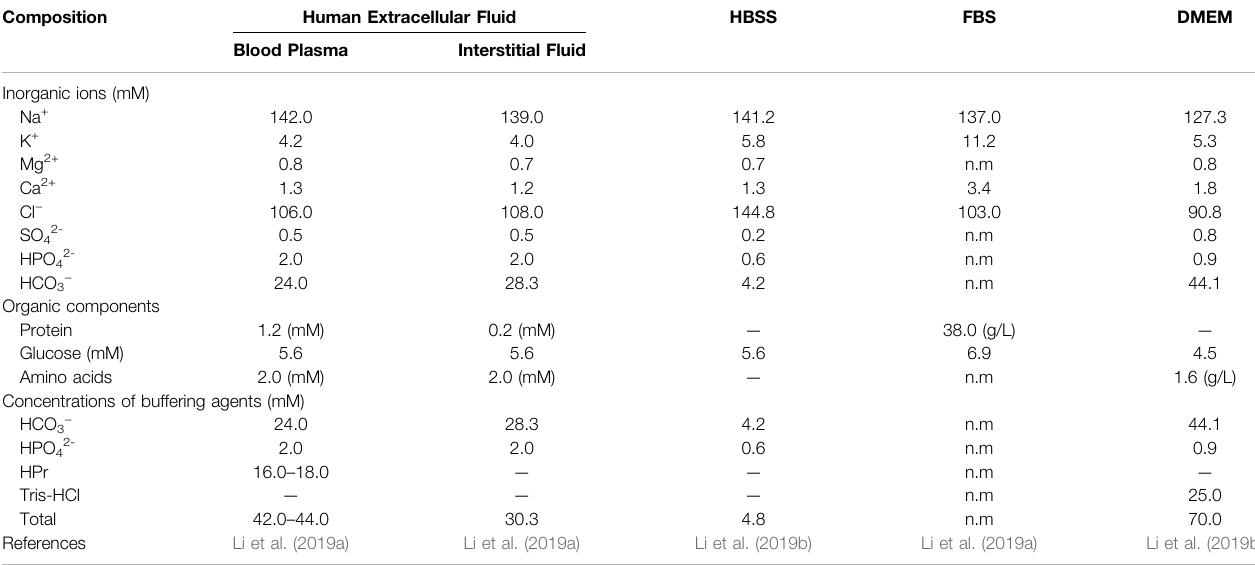
TABLE 1 | The main compositions of DMEM, McCoy ’ s 5A, and FBS, compared to the human extracellular fl uid. Composition Human Extracellular Fluid